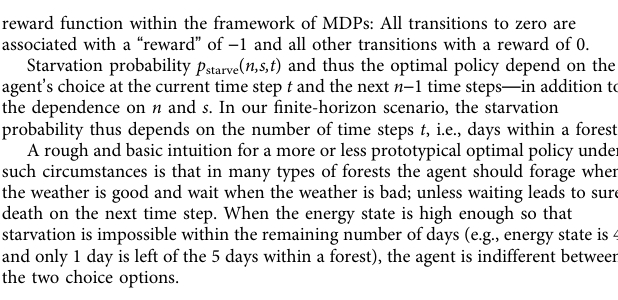
any given model is more frequent than all other models in the population 53